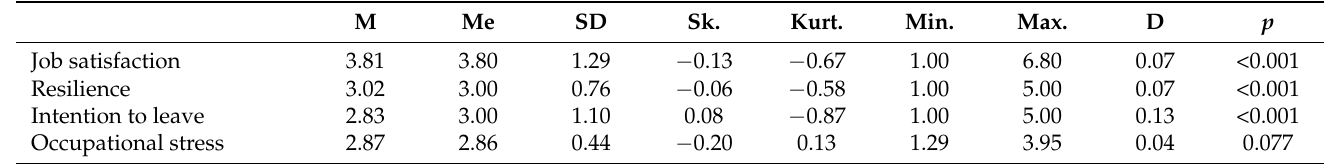
Table 1. Descriptive statistics and the Kolmogorov–Smirnov test of distribution normality. M Me SD